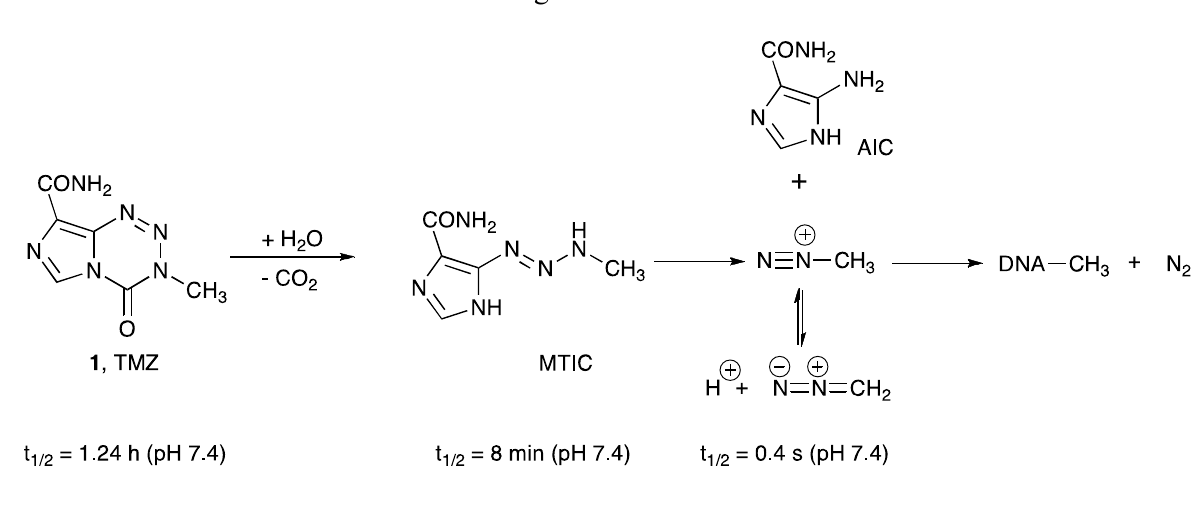
Scheme 1. Prodrug activation of temozolomide.